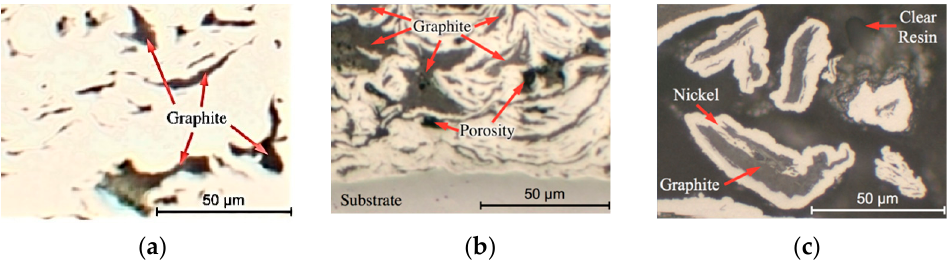
Figure 9. Micrographs showing ( a ) NCG particles co-deposited with nickel powder, ( b ) NCG alone, and ( c ) raw NCG powder before spraying for comparison.